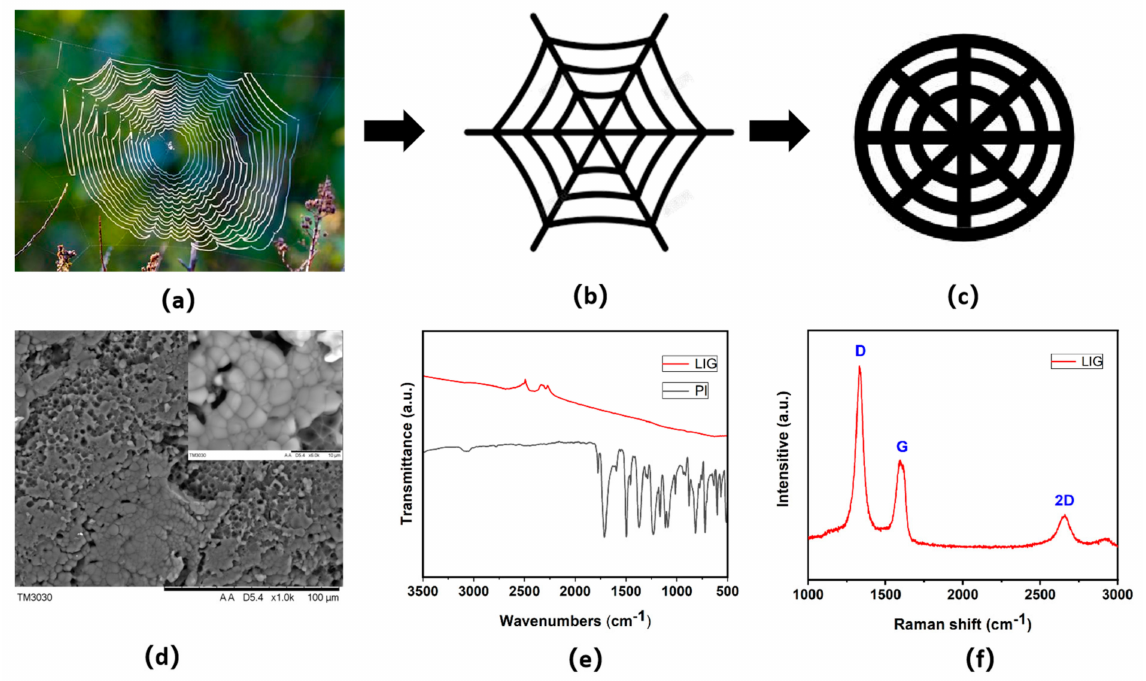
Figure 1. ( a ) Natural spider web; ( b ) Spider web planar structure; ( c ) Improved spider web structure; ( d ) SEM microscopy of the structure at 100 µ m and 10 µ m; ( e ) IR spectra of LIG with PI; ( f ) Raman spectra of